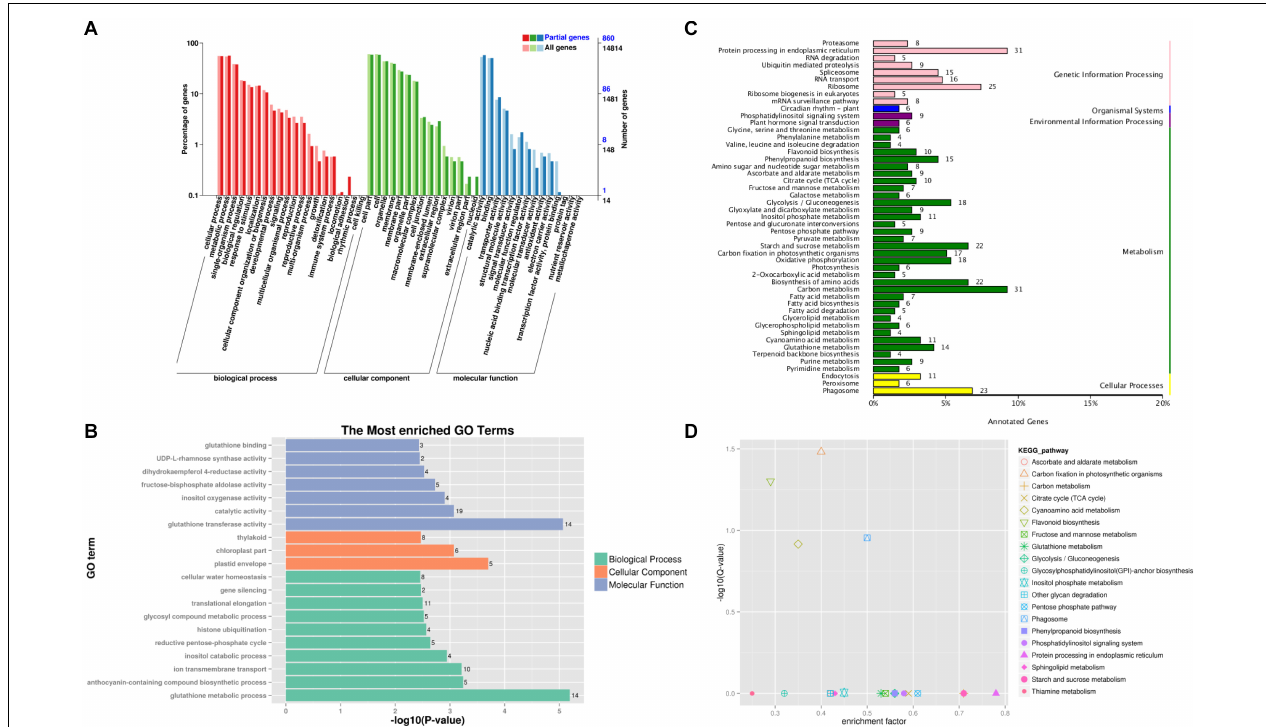
FIGURE 4 | Gene Ontology (GO) and Kyoto Encyclopedia of Genes and Genomes (KEGG) pathway functional classification and enrichment analysis of the 1,066 differentially expressed genes (DEGs) identified from Venn diagram. (A) Functional classification of DEGs based on GO categorization. (B) GO enrichment analysis of the DEGs. (C) Pathway assignment based on the KEGG classification metabolism categories. (D) KEGG pathway enrichment analysis of the